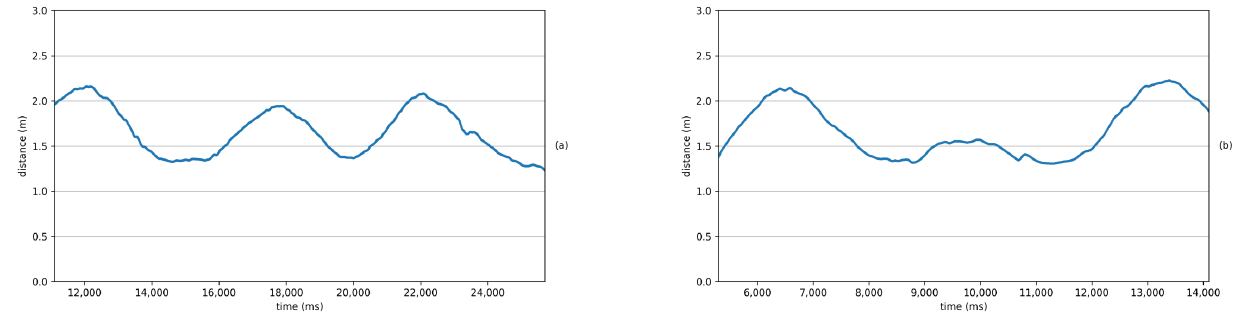
Figure 9. Distance from the origin for two paired subjects in the turning phase: ( a ) patient subject; ( b ) control